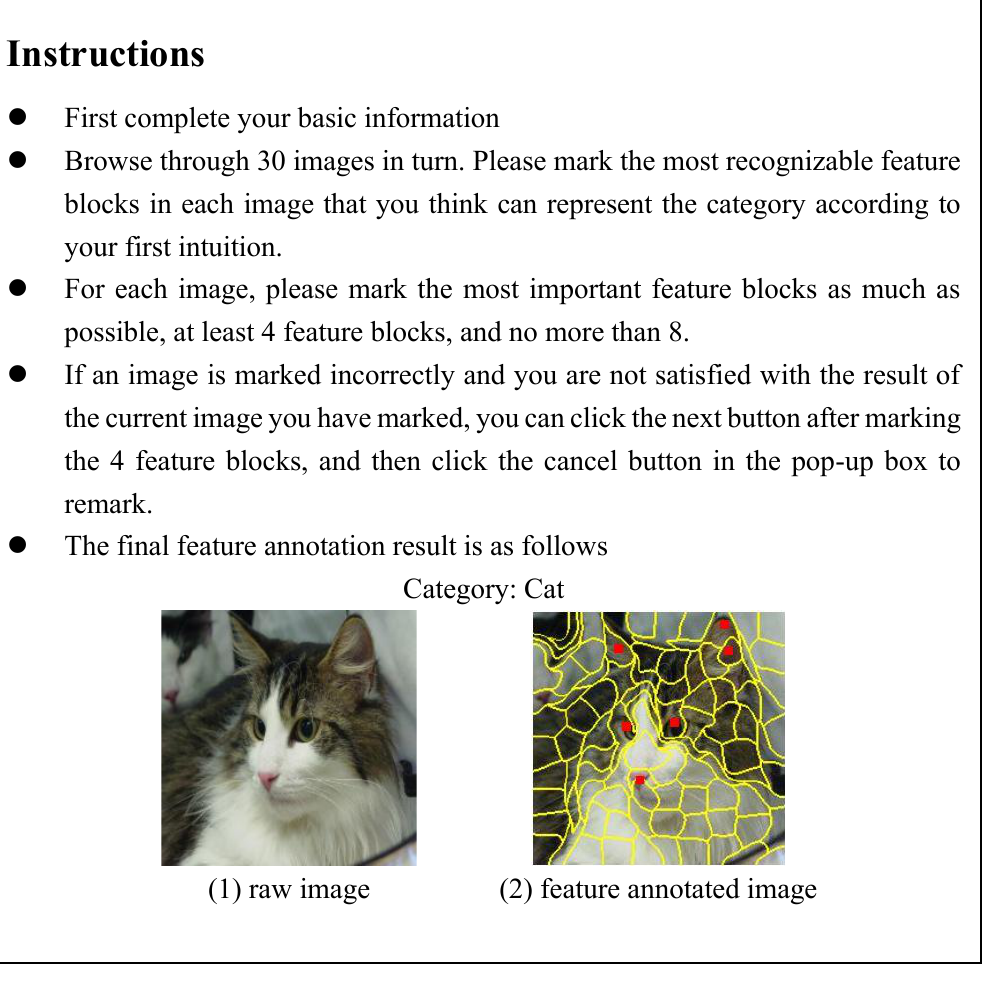
Figure A2. Feature marking instruction.